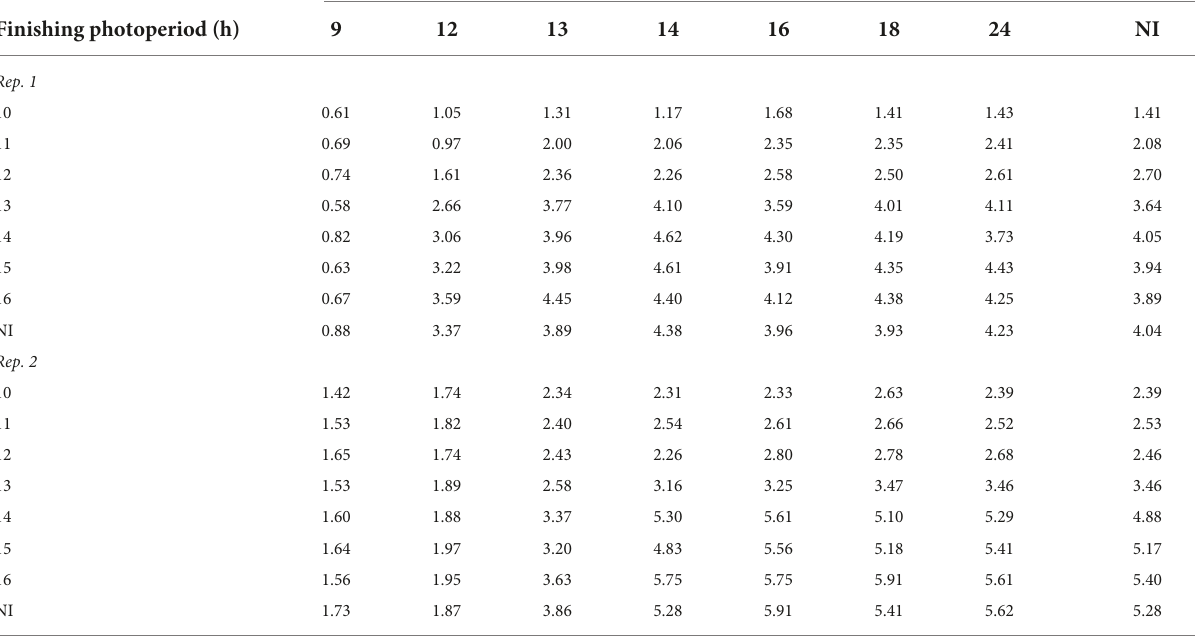
TABLE 4 Effects of young-plant photoperiod (9, 12, 13, 14, 16, 18, and 24 h, or a 4-h NI) and finishing photoperiod (10, 11, 12, 13, 14, 15, and 16 h, or a 4-h NI) on stem caliper (mm) of witchgrass ‘Frosted Explosion’ ( Panicum capillare ) at the open flower. Young-plant photoperiod (h)